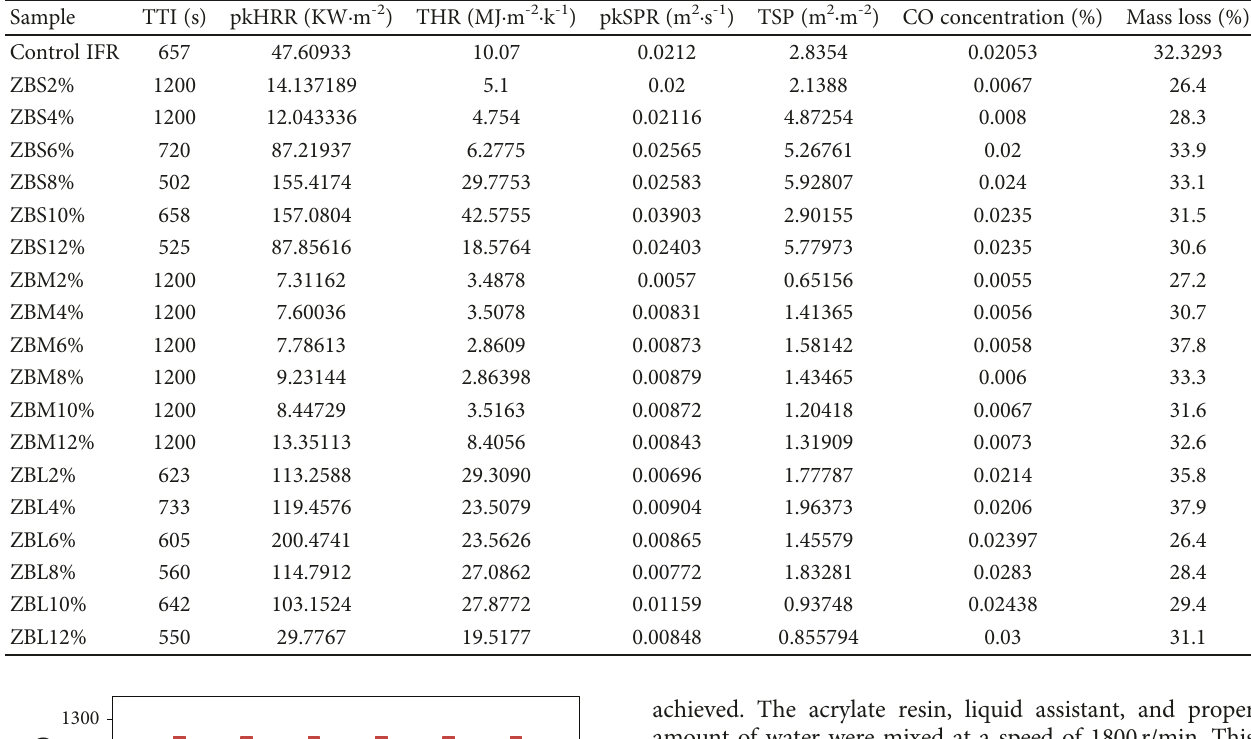
Table 2: Results of a calorimeter test.